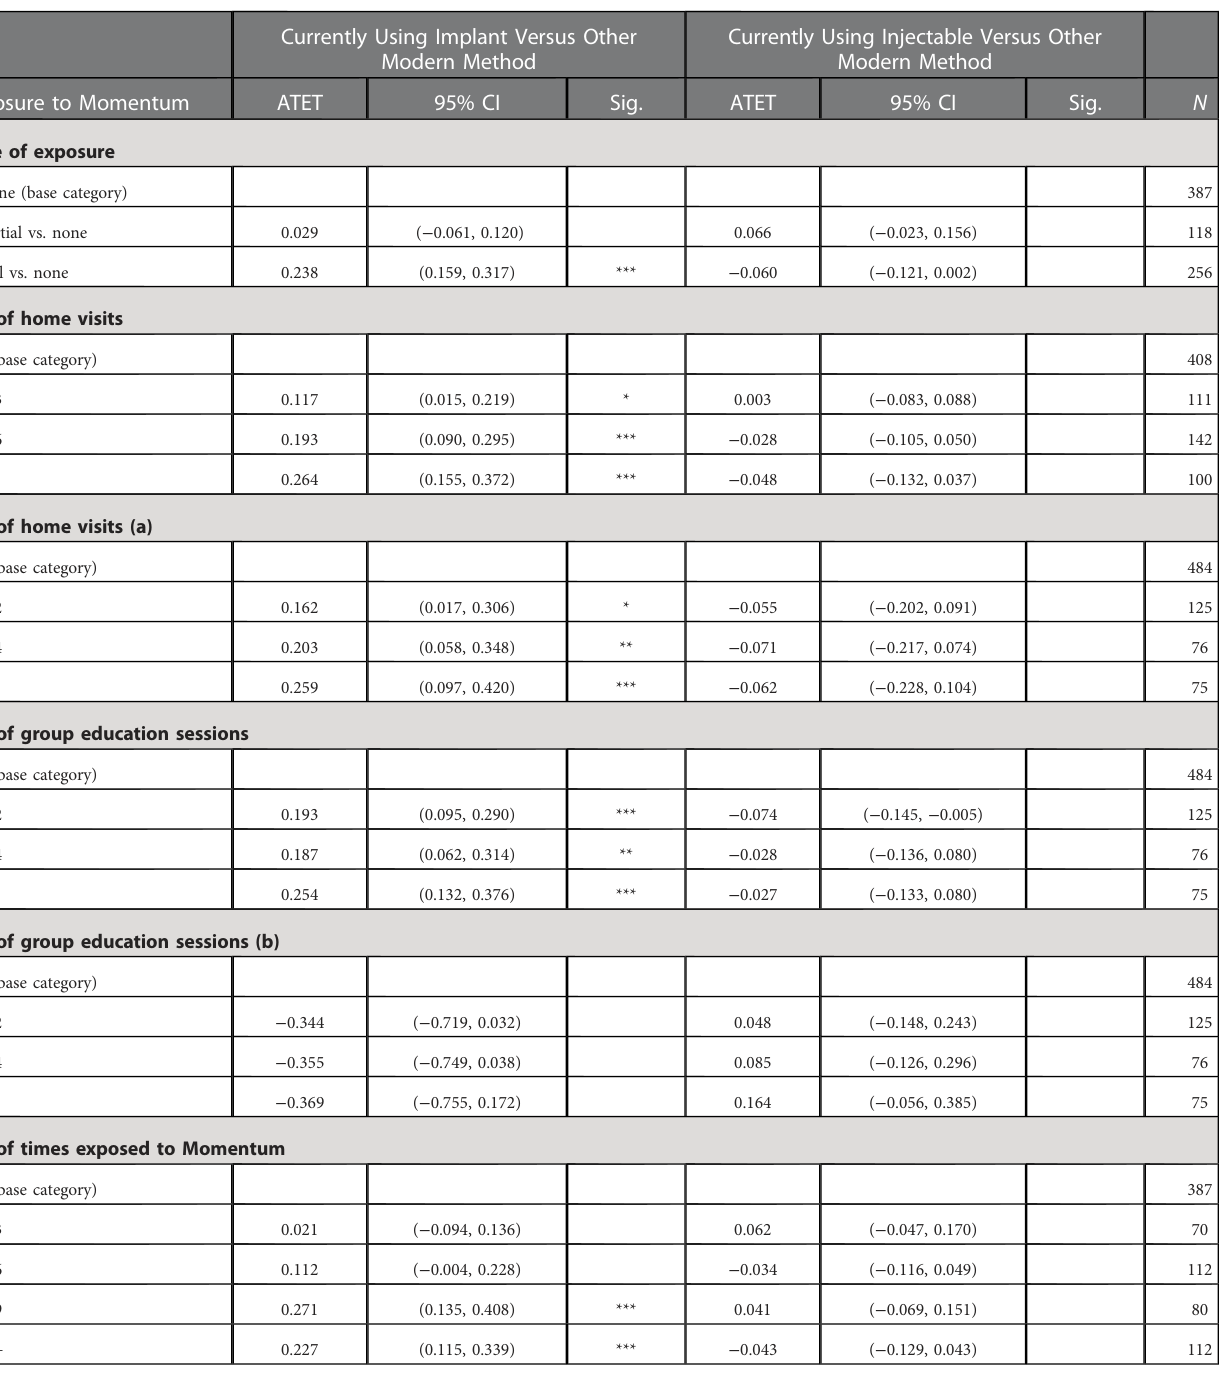
TABLE 5 Average treatment effects on the treated, 95% con fi dence intervals and p -values for current use of injectables vs. other methods and current use of implants vs. other methods by level of exposure to Momentum interventions, fi rst-time mothers age 15 – 24 who were currently using a modern method,